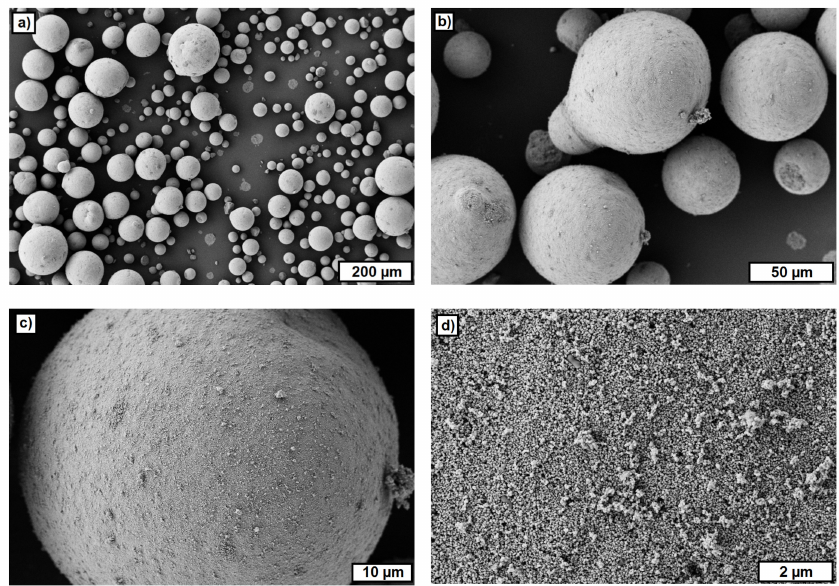
Figure 9. FESEM images of untreated zirconia powder. ( a ) ZrO 2 -granulates, overview; ( b ) ZrO 2 -granulates, detail; ( c ) single ZrO 2 -granulate; ( d ) surface of ZrO 2 -granulate.